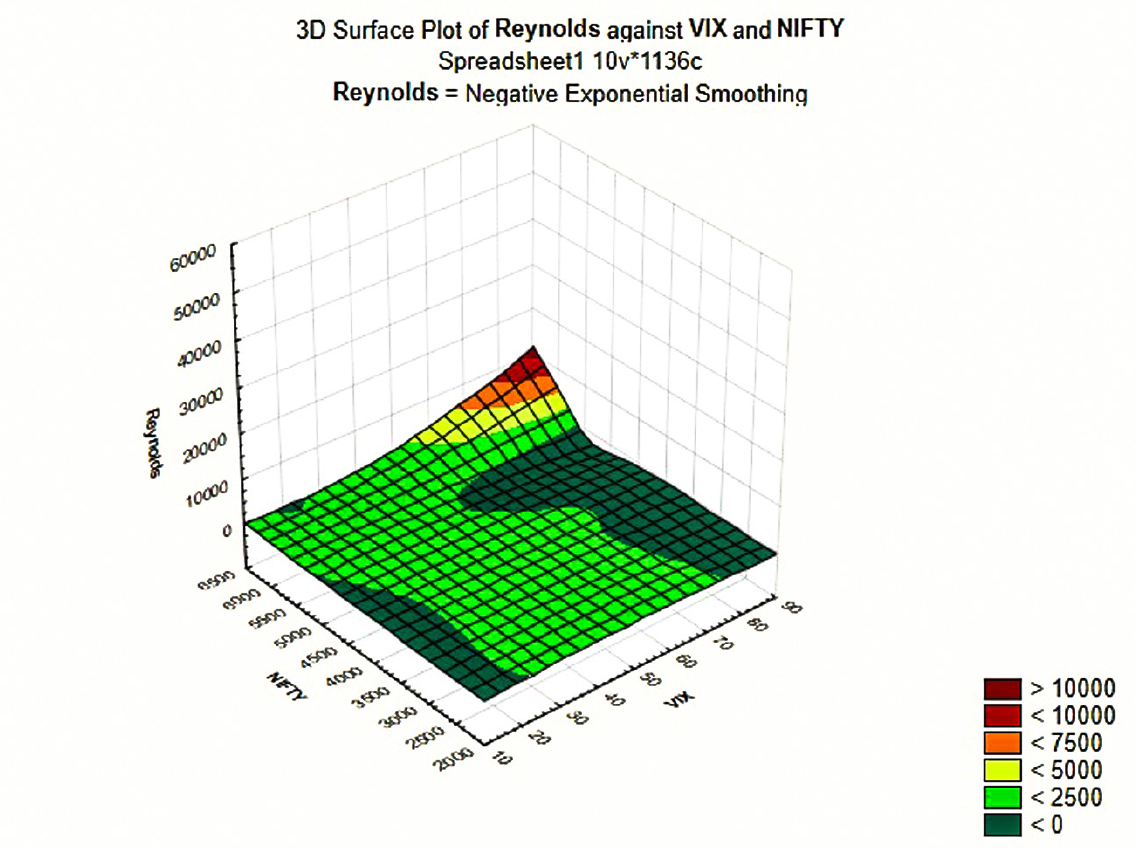
Figure 2. The Reynolds number is plotted with CNX Nifty and the volatility indicator CBOE VIX in the second zone (2007 to 2011); local maxima is observed at higher levels of CNX Nifty